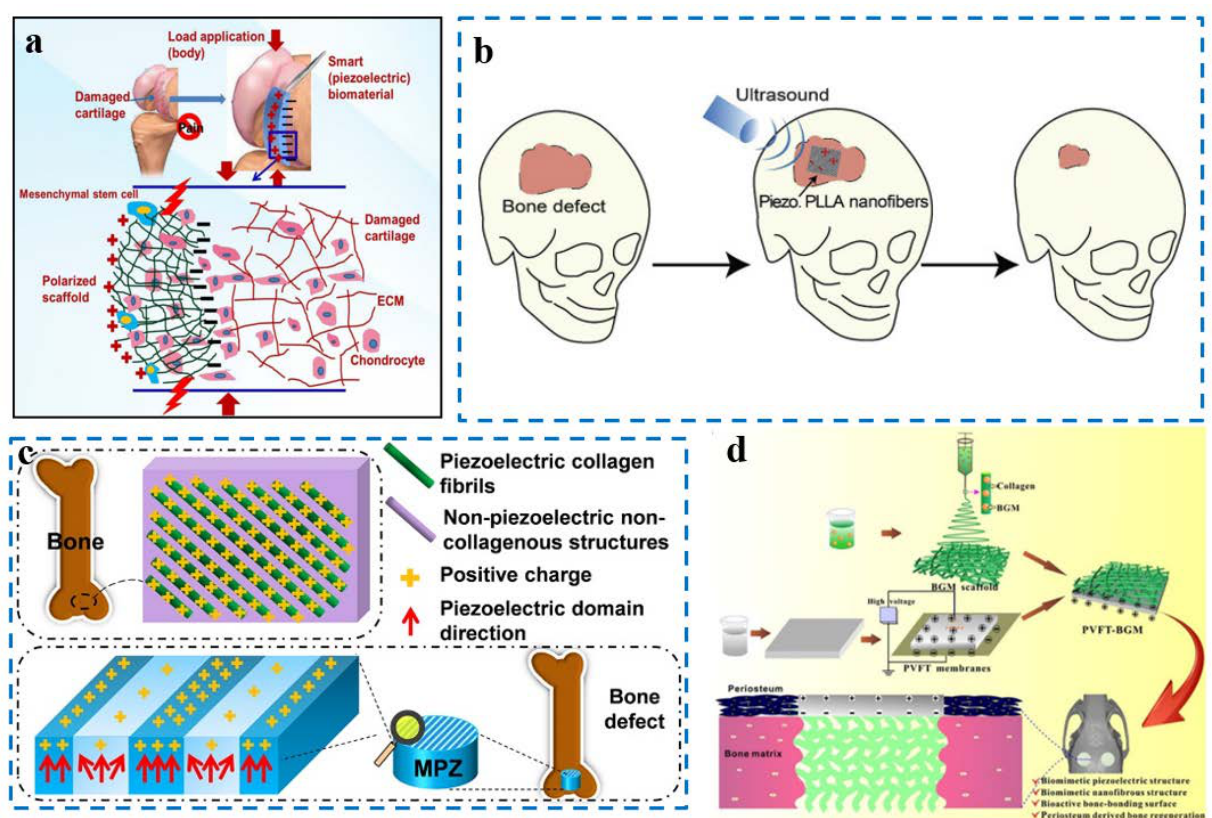
Figure 6. ( a ) Manufacturing processes and bionic applications of degradable piezoelectric scaffolds and the induction of chondrocytes based on the relationship between degradation and piezoelectric effects [70] ; ( b ) biodegradable piezoelectric PLLA nanofibers are used in combination with non- invasive ultrasound (US) to generate stable electrical stimulation for bone regeneration [71] ; ( c ) MPZs were constructed to mimic piezoelectric microregions in native bone for bone defect repair (MPZs were manufactured by setting selective laser irradiation and polarization on the KNN sur- face, then implanted to a bone defect model to assess bone regeneration) [72] ; ( d ) schematic diagram of the manufacturing process and potential advantages of PVFT-BGM scaffold for bone regenera- tion [73] .